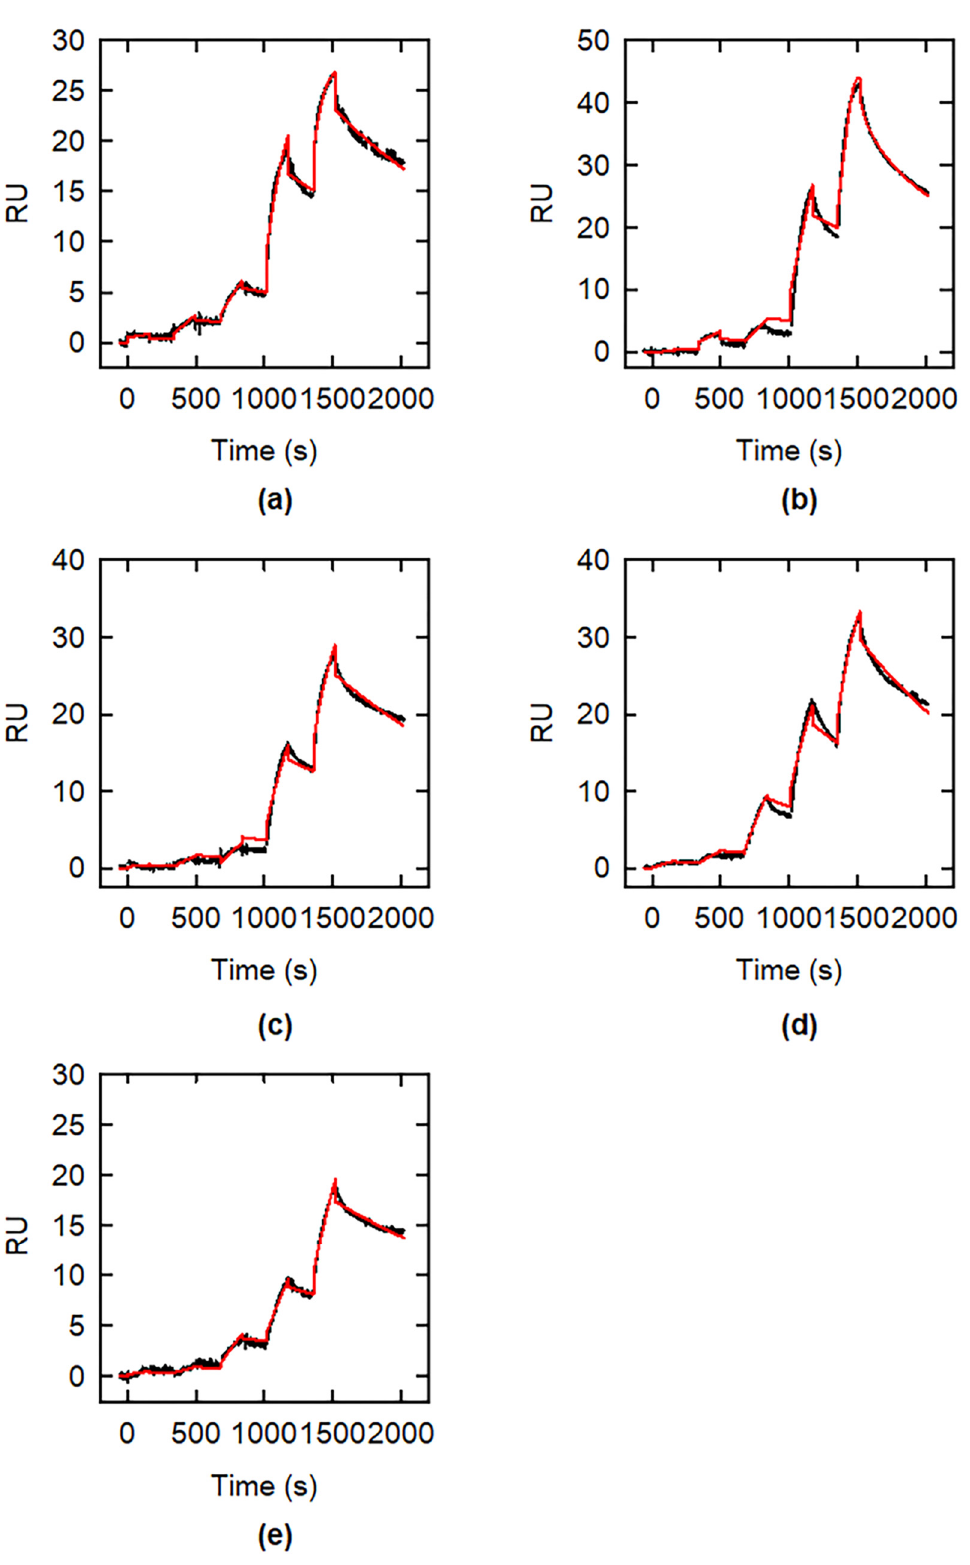
Figure 3. Kinetics of formation of EcCS complex in the absence ( a ) and in the presence of 0.15 µM ( b ), 0.3 µM ( c ), 1 µM ( d ) or 2 µM ( e ) UPAR415. Data were fitted to the Langmuir 1:1 binding model (red lines). SAT was injected at five sequential concentrations of 0.5, 2.5, 5, 25, and 50 nM ( a – c ) or 2.5, 5, 25, 50, and 100 nM ( d , e ). Protein concentrations are expressed as monomers.